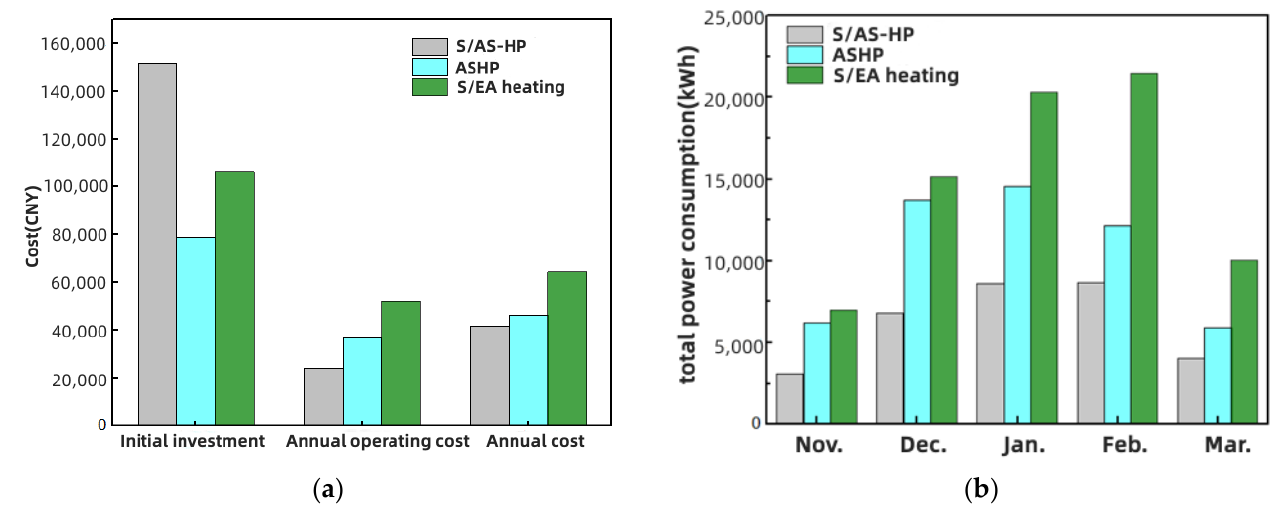
Figure 9. Economic comparison of various systems. ( a ) Comparison of system costs. ( b ) Comparison of the total power consumption rates of each system.